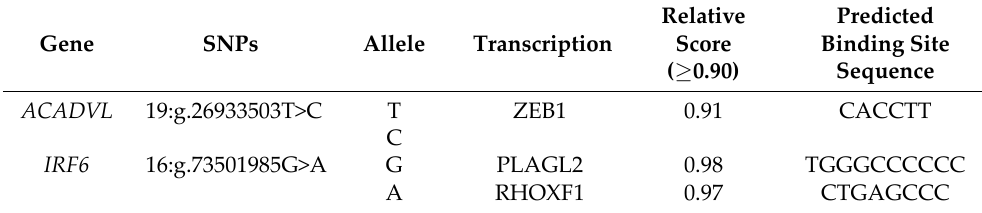
Table 4. Transcription factor binding site (TFBS) predictions for the ADACVL and IRF6 genes. Relative Predicted Gene SNPs Allele Transcription Score Binding Site ( ≥ 0.90) Sequence ACADVL 19:g.26933503T>C T ZEB1 0.91 CACCTT C IRF6 16:g.73501985G>A G PLAGL2 0.98 TGGGCCCCCC A RHOXF1 0.97